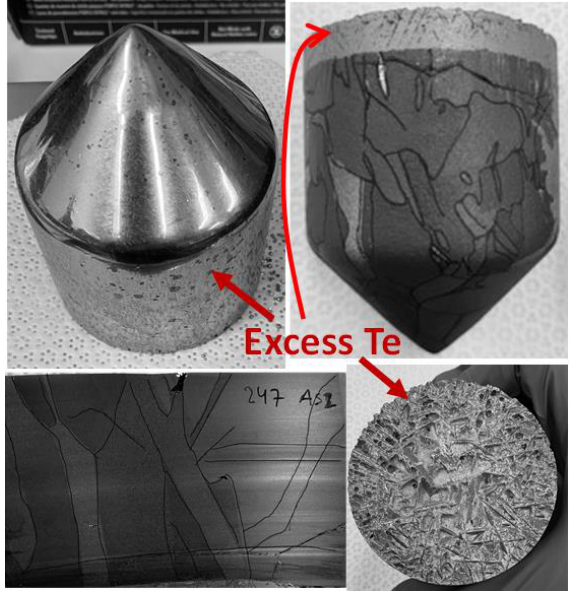
Figure 2. Pictures of the CRY-4 ingot showing Te accumulation at the heel and at the surface of the ingot and the axial wafer from the bulk region with marked small grains.